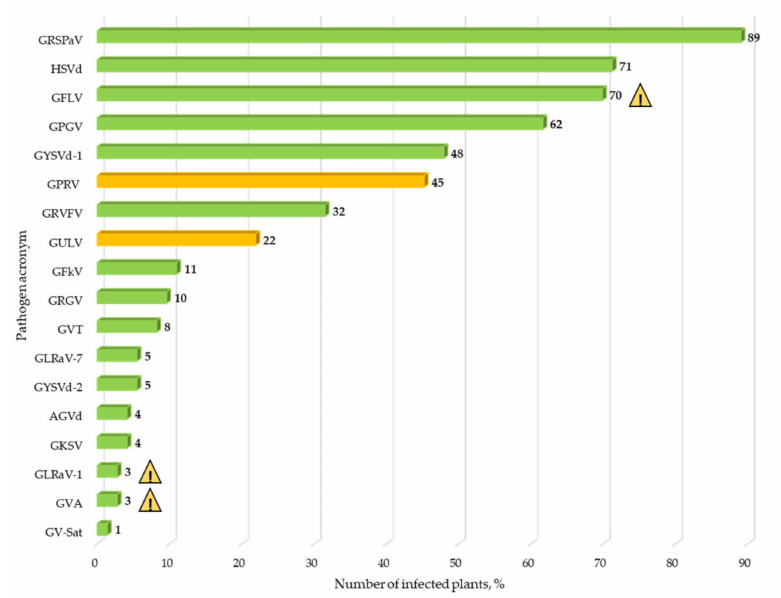
Figure 8. Frequency of spread of grapevine viruses and virus-like organisms in Dagestan ampelographic collections (percentage of the total number of collected samples). Two new viruses are marked orange. Economically significant viruses are shown as